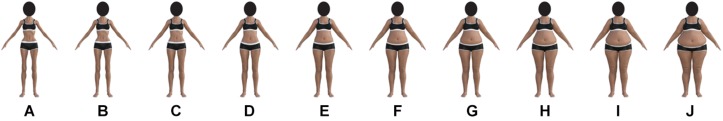
Computer-rendered female body stimuli used in the Figure Rating Scale. Labels A–J correspond to bodies with increasing BMI.